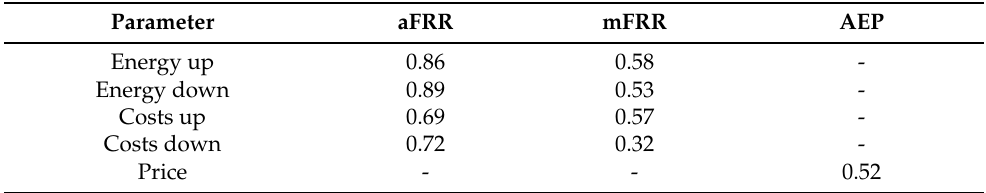
Table 7. Correlation factors between historic values [26] and time series resulting from the validation scenario “1 no smart balancing”. Parameter aFRR mFRR AEP Energy up 0.86 0.58 - Energy down